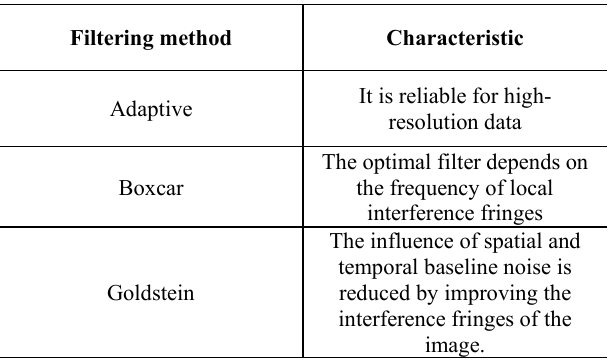
Figure 5. Interference diagram after